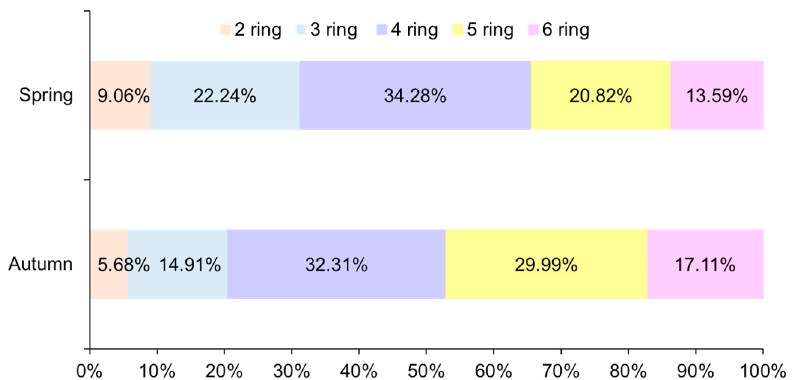
Figure 3. Ring number distribution of the PAHs in farmland soils in autumn and spring.